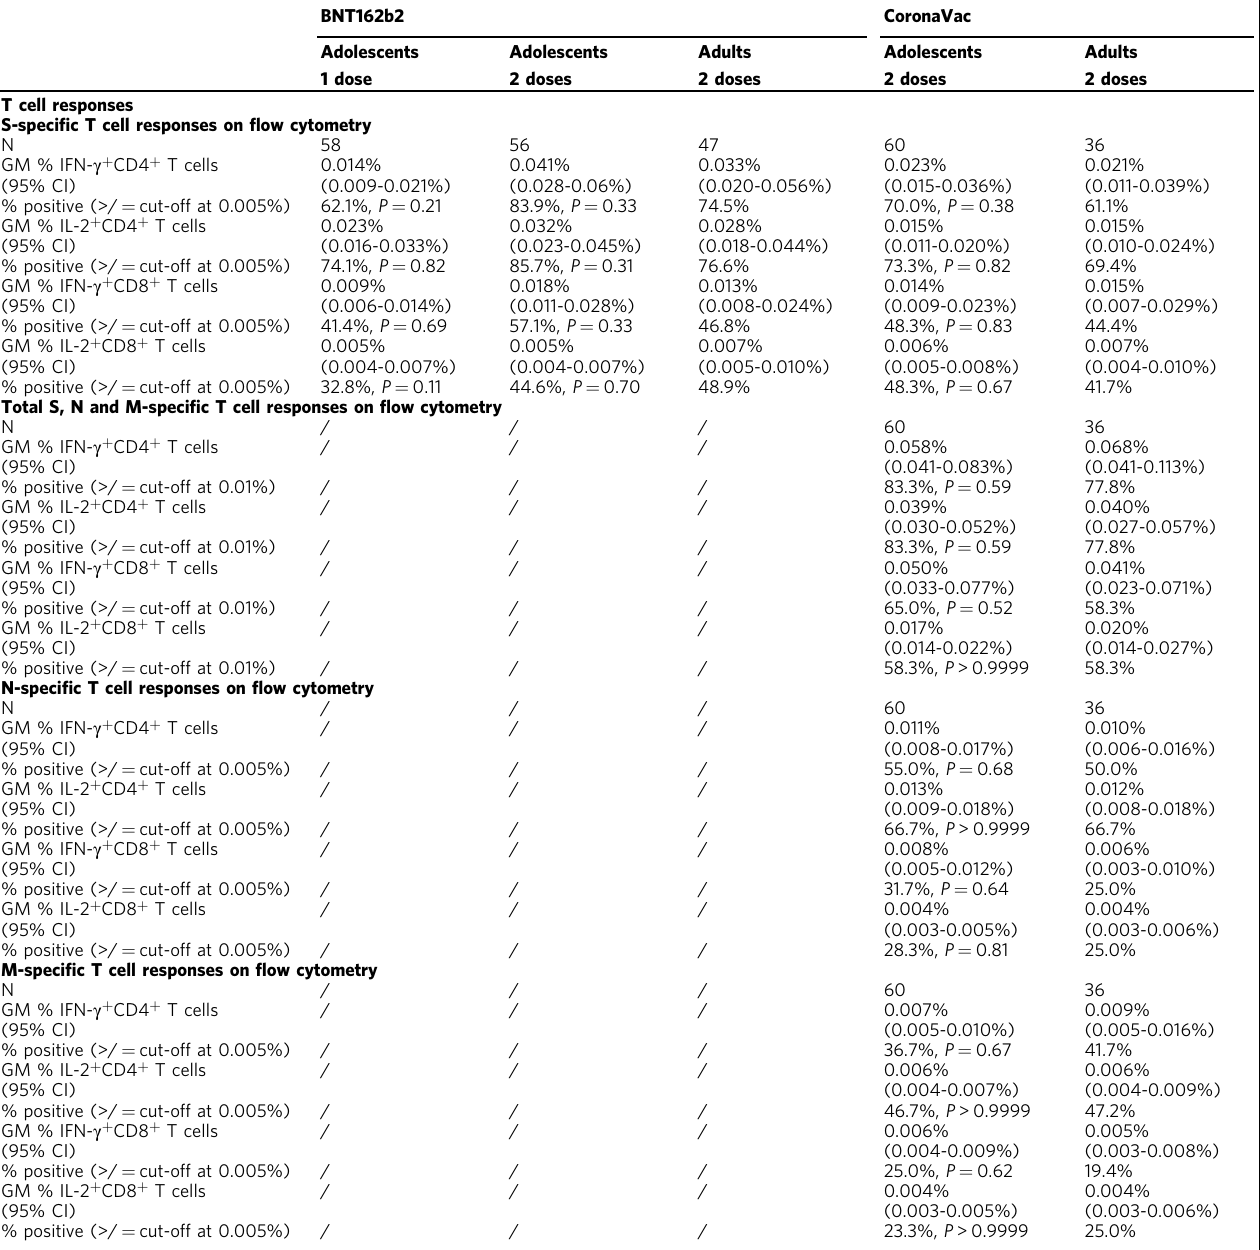
Table 2 Cellular immunogenicity outcomes in evaluable analysis populations by vaccine